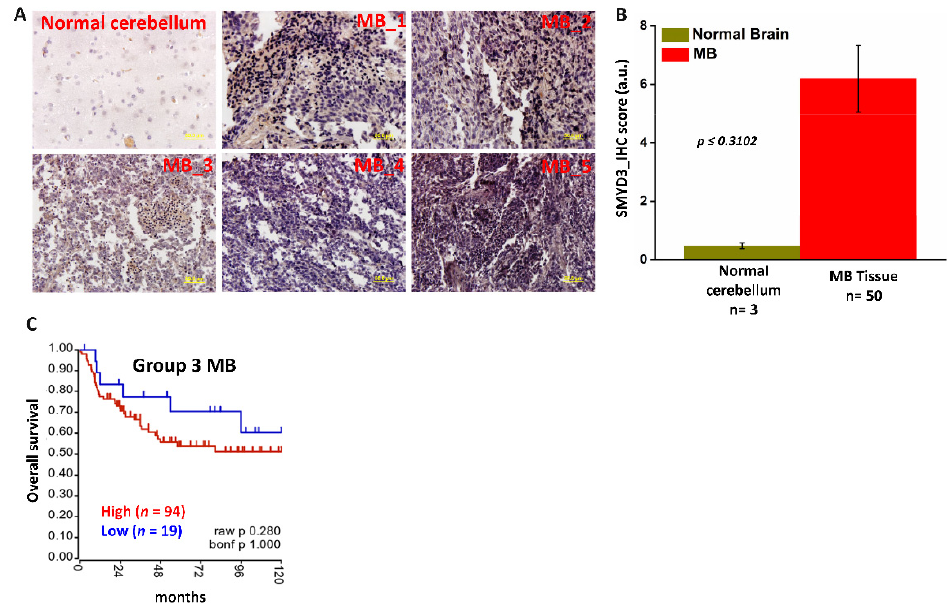
Figure 2. High SMYD3 expression is associated with reduced survival in MB. ( A ) Immunohisto- chemical (IHC) staining of normal human cerebellar tissue and MB tissues (magnification 40x; scale bar, 50 µ m) ( B ) Q score analysis was performed using (staining intensity_Intden/no. of positive cells) ImageJ software to quantify SMYD3 protein expression. Staining for IHC analysis of MB ( n = 50) and controls ( n = 3) was performed per field (4×/per specimen) ( C ) Kaplan–Meier survival plot showing the overall survival probability of Group 3 MB patients with high (red) or low (blue) SMYD3 transcripts. 3.2. SMYD3 Is Primarily Expressed in the Nuclei of MB Cells and Targets Cell Cycle Regulators In addition to epigenetic regulation, SMYD3 can also influence signaling pathways outside of the nucleus [23]. Immunoblot analysis of cytoplasmic and nuclear extracts ob- tained from the D283, D425, and D458 cells revealed higher expression of SMYD3 protein in the nucleus (Figure 3A–C). To identify potential targets of SMYD3, the nuclear extracts from D283 cells were immunoprecipitated and the SMYD3-bound fractions were subse- quently analyzed by mass spectrometry (Table S1). In addition to histones and molecules involved in DNA binding, our analysis indicates that SMYD3 targets proteins involved in cell cycle regulation including CCND1, CCNB2, and KDM2A. These findings suggest that SMYD3 promotes MB cell survival possibly through protein-protein interactions and tran- scriptional regulation in the